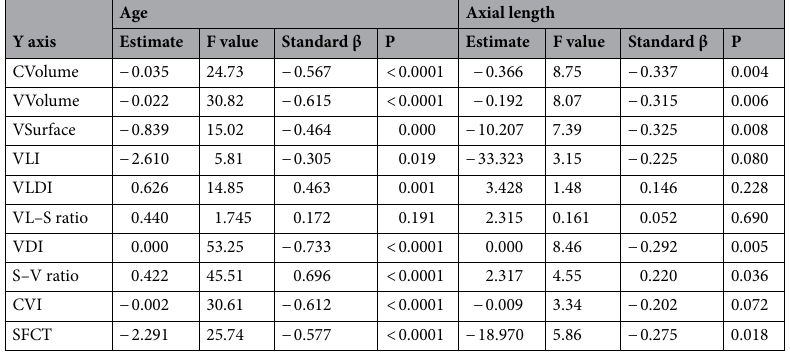
Table 6. Multivariate analysis. Each parameter and age, axial